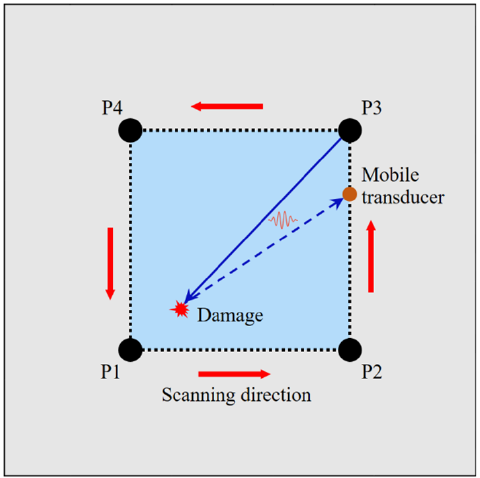
Figure 4. Schematic diagram of path scanning using mobile transducer.